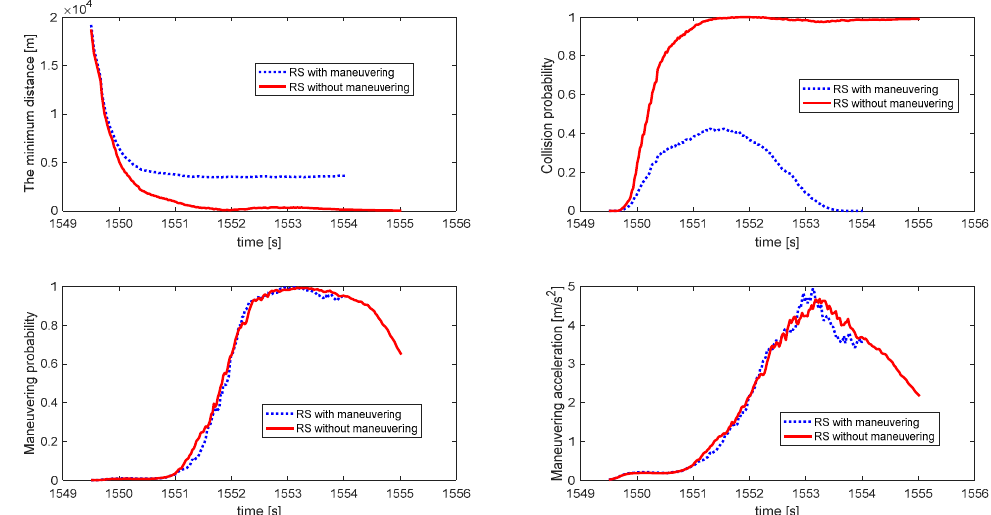
Figure 13. Minimum distances and collision probability between NCSO and RS, and maneuvering probability and maneuvering accelerations of NCSO for second simulation.